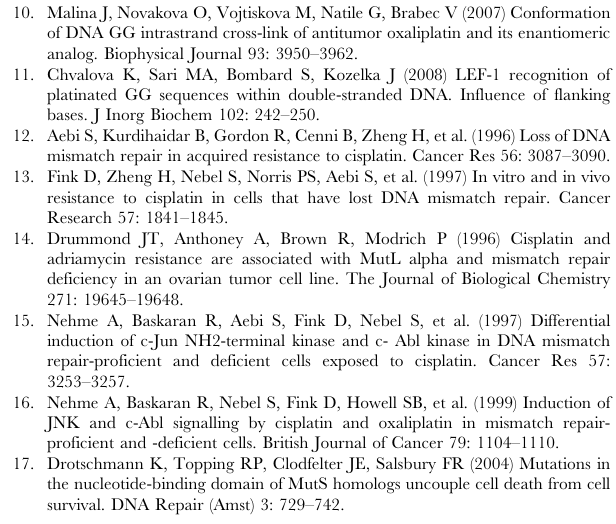
GG strand ( A and C ) and CC strand ( B and D ) are shown. ( A ) and ( B ) correspond to the OX-TGGT duplex and ( C ) and ( D ) correspond to the undamaged TGGT duplex. Thick and dashed lines show H2 99 and H2 9 , respectively. (**) designate upfield- shifted H2 9 resonances for T5, C18, and C19 in the 12-mer OX- GG duplex, compared to those in the undamaged 12-mer GG duplex (*). Figure S3 Root-mean-square deviation (RMSD) values for the MD simulations plotted as a function of time. The RMSD values for each of the 5 simulations compared to the corresponding starting structure for the undamaged DNA, CP- DNA and OX-DNA are shown for the full 10 ns of each simulation. RMSD at time (t) represents the average of RMSD in a 250 ps bin centered at t (running average). The five simulation trajectories performed using the NMR structure of undamaged DNA, X-ray crystal structures and NMR structures of CP-DNA and OX-DNA as starting structures with different initial MD velocities are represented in black, red, blue, green and violet. The starting structure corresponding to each plot is represented as CP CRY, OX CRY, CP NMR, OX NMR and BDNA for crystal structure of CP-DNA, crystal structure of OX-DNA, NMR structure of CP-DNA, NMR structure of OX-DNA and the NMR structure of undamaged DNA in the TGGT sequence context. Figure S4 Helical parameters showing sequence specif- ic effects while comparing OX-DNA and undamaged DNA in the TGGT and AGGC sequence context. Histograms of the helical parameters showing the most significant differences between either OX-DNA or undamaged DNA in the TGGT and AGGC sequence contexts are plotted. The frequency distribution for a particular MD ensemble was obtained from the structures corresponding to the final 6 ns of each simulation, resulting in 60000 structures for undamaged DNA and 60000 structures for OX-DNA being used for histogram construction. The distributions of undamaged DNA and OX-DNA in the AGGC sequence context are plotted with solid and dashed black lines, respectively. The distributions of undamaged DNA and OX- DNA in the TGGT sequence contexts are plotted with solid and dashed red lines, respectively. The helical parameters shown are: 5–6 slide ( A ), 5–20 propellor twist ( B ), 7–18 buckle ( C ), 8–17